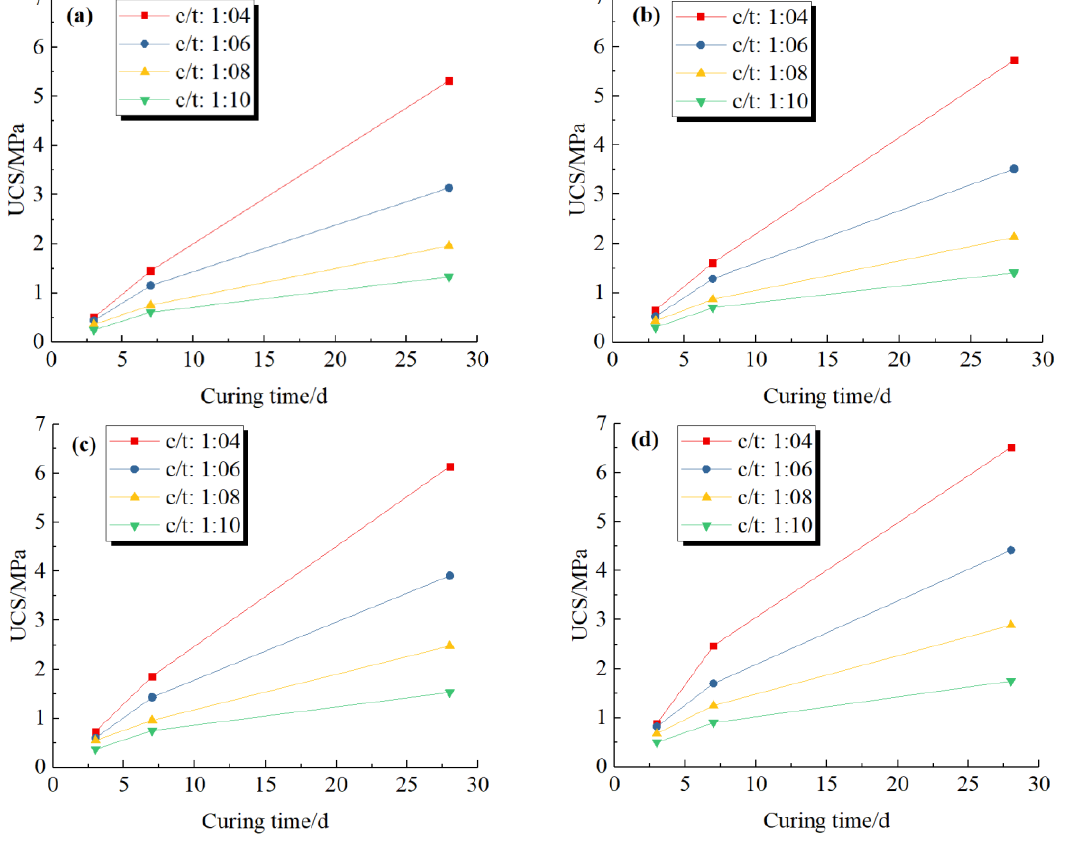
Figure 10. Relations between curing time and UCS of CTB: ( a ) SD: 65%; ( b ) SD: 68%; ( c ) SD: 70%; ( d ) SD: 72%.